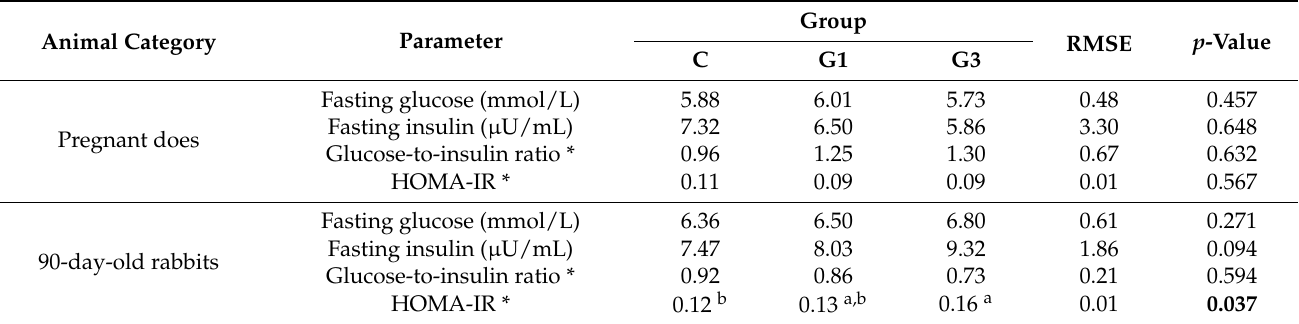
Table 2. Fasting derived indices of insulin resistance in pregnant does and 90-day-old rab- bits of control group (C, n = 13/category) and groups with 1% (G1, n = 13/category) and 3% (G3, n = 13/category) of Goji berry.